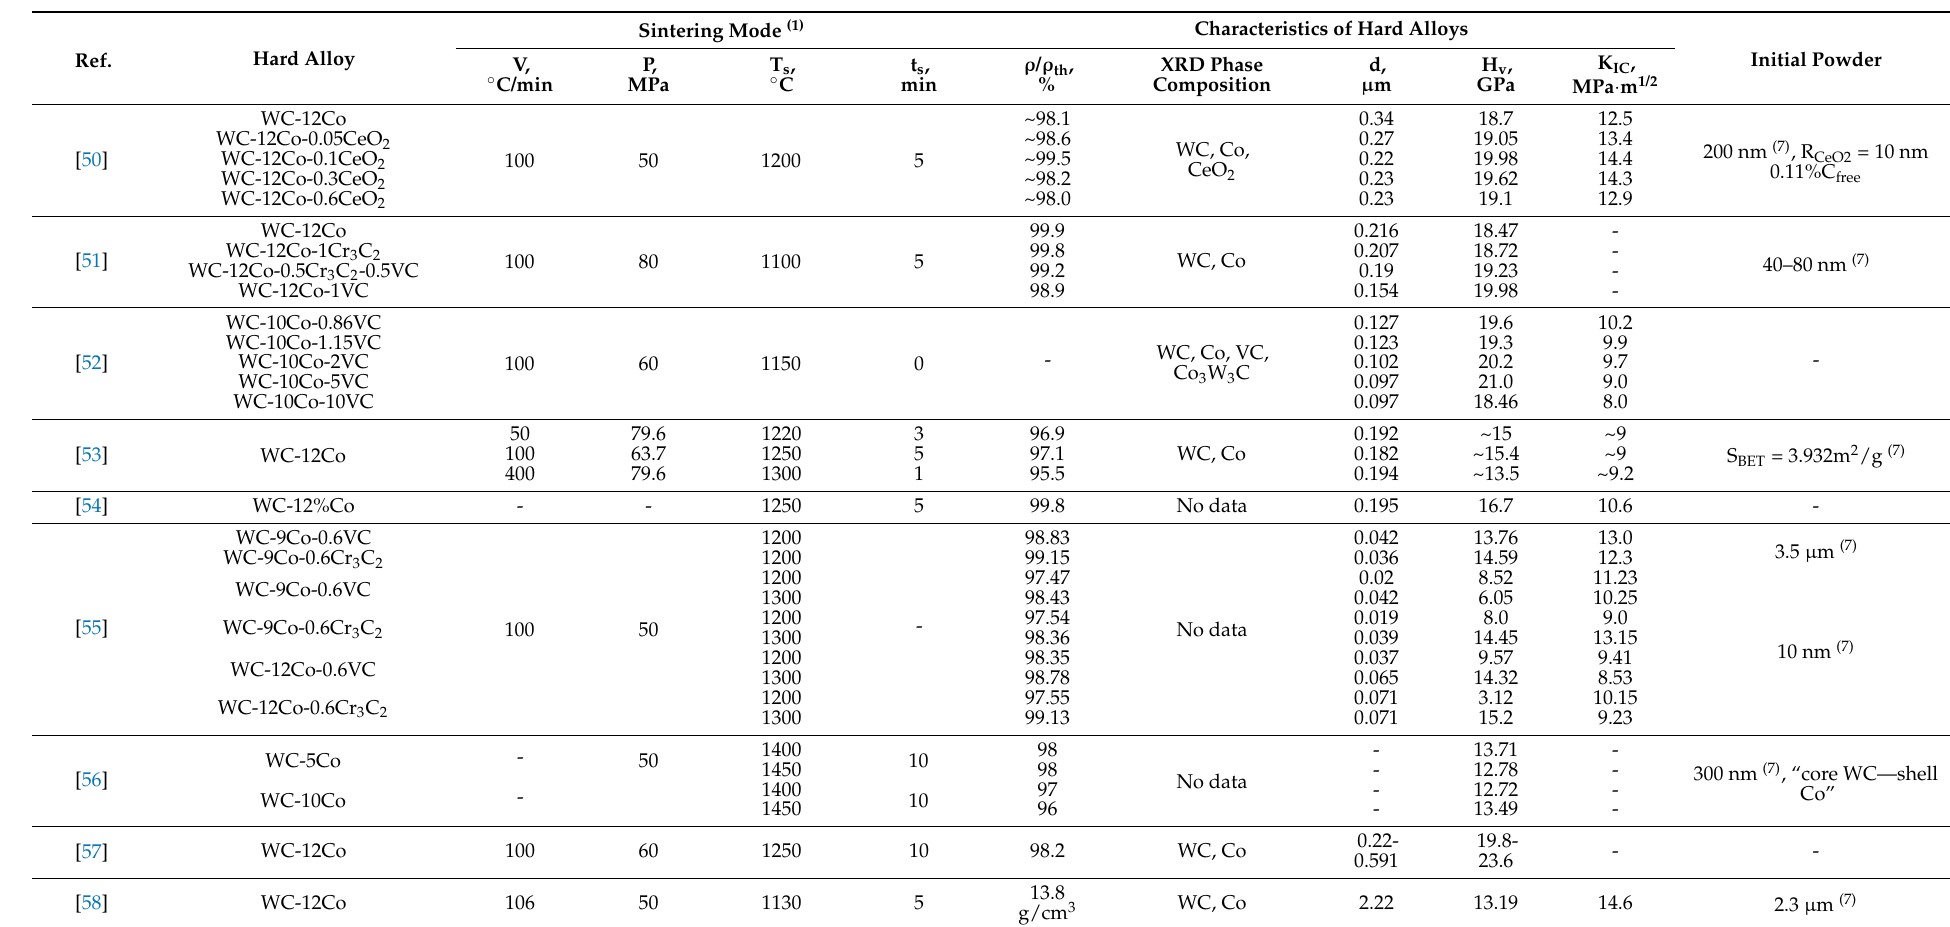
Evan formula; (6) —Schubert formula (the rest values in the table use calculations according to the Palmquist formula); (7) —mean sizes of initial WC